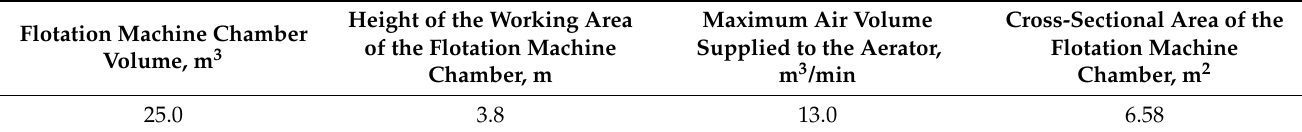
Table 4. Simulated flotation cell’s parameters.